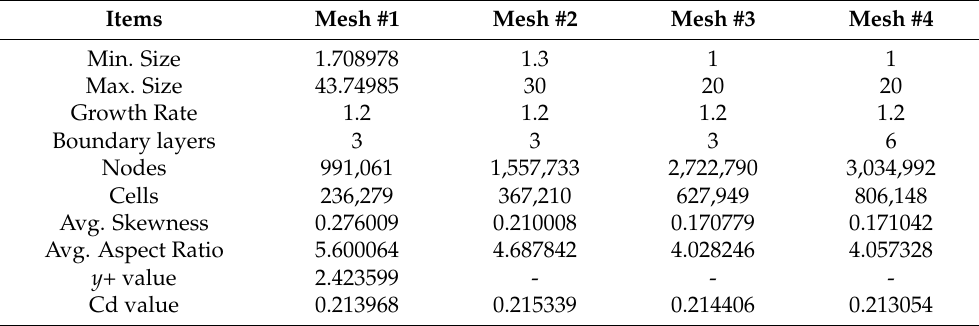
Table 1. Mesh quality parameter